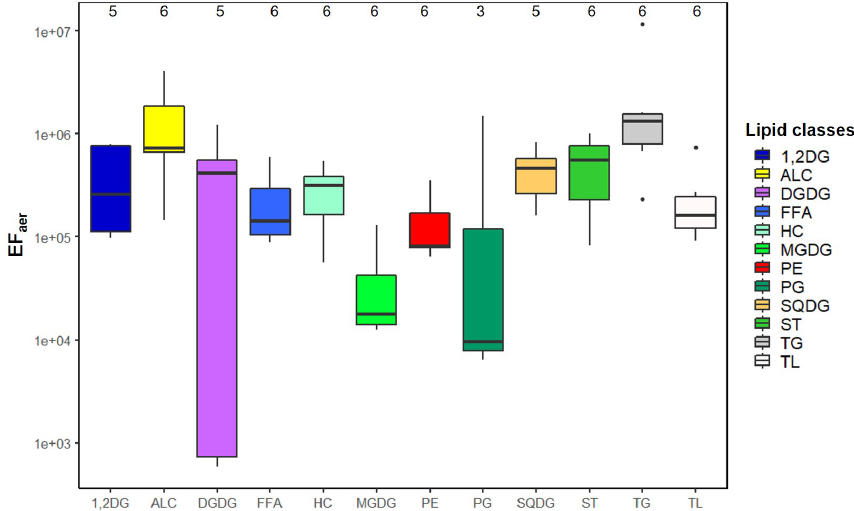
Figure 4. Boxplot of the enrichment factor aerosol (EF aer ) of the individual lipid classes and total lipids (TL) at the CVAO including the median and the 25th and 75th percentiles; a further explanation is given in Fig.